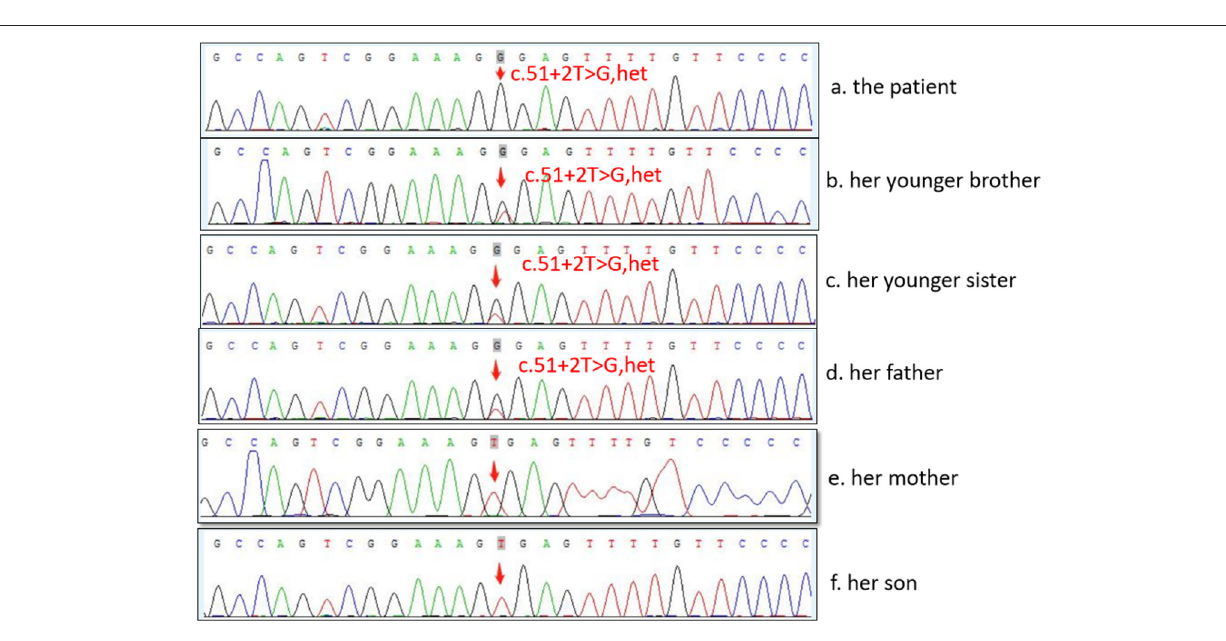
FIGURE 2 | Sequence analysis of ATP7B gene in the